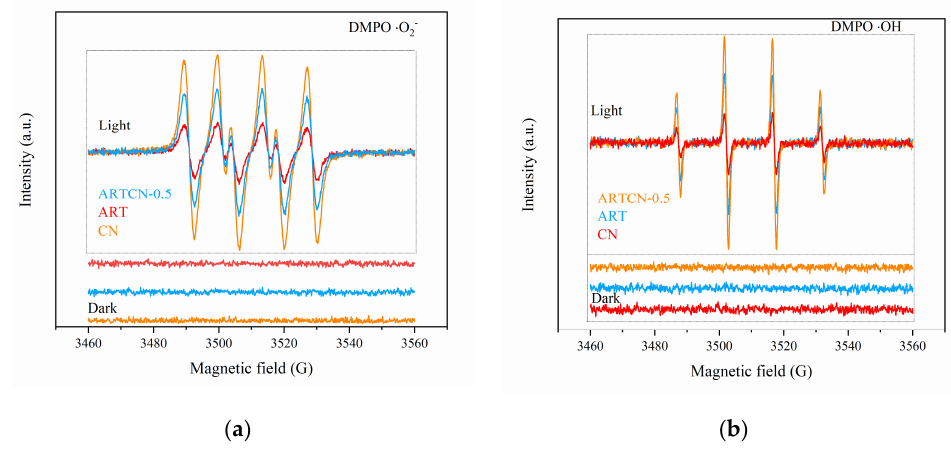
Figure 10. ESR profiles of DMPO ·O 2− ( a ) and DMPO ·OH ( b ) of the samples.